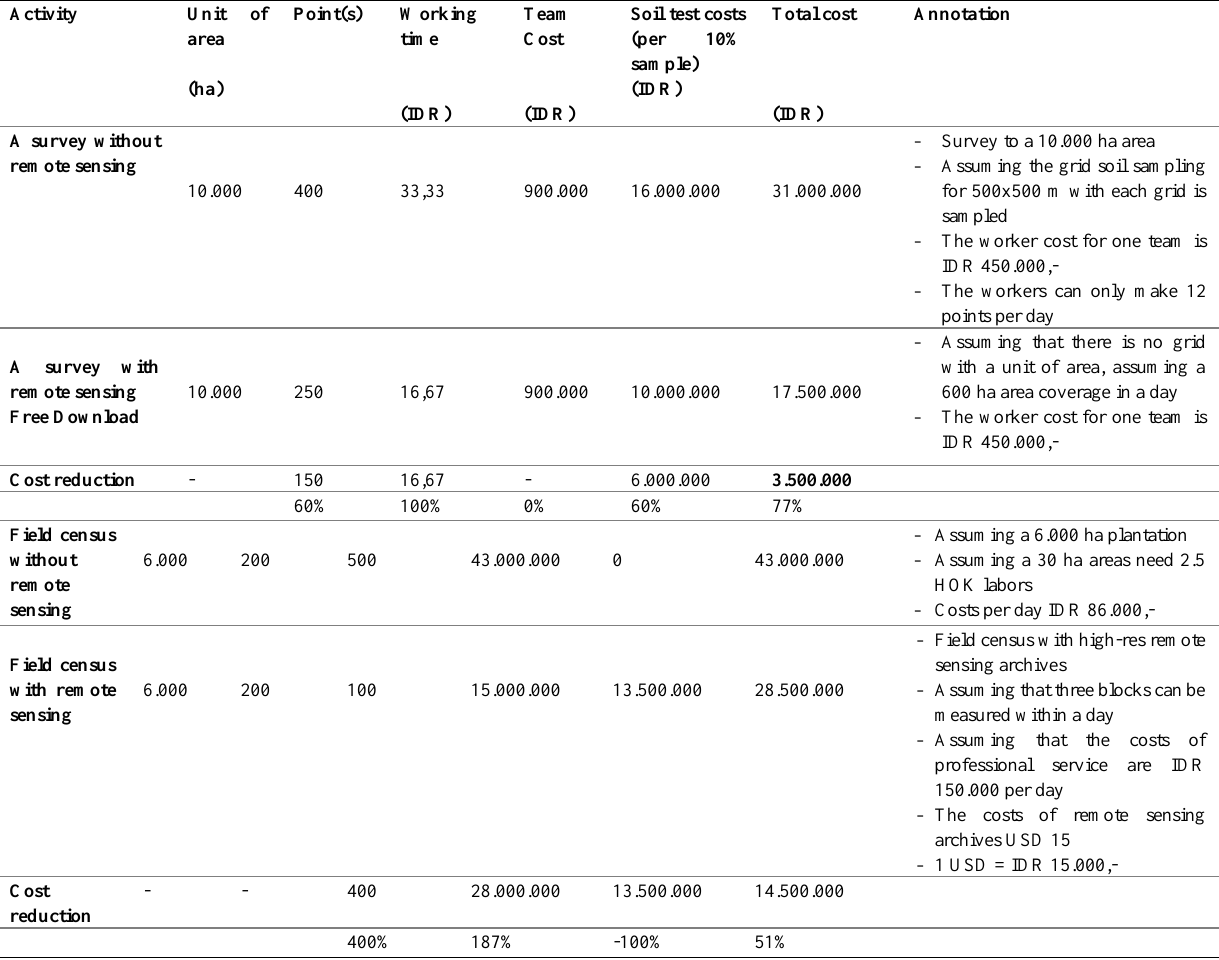
Table 1: The Significance of Remote Sensing Generated-Data and Information in Palm Oil Research And Development Department